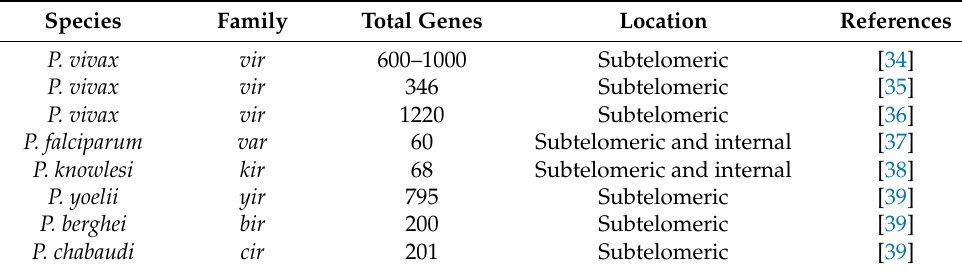
Table 1. The Plasmodium PIR multigene